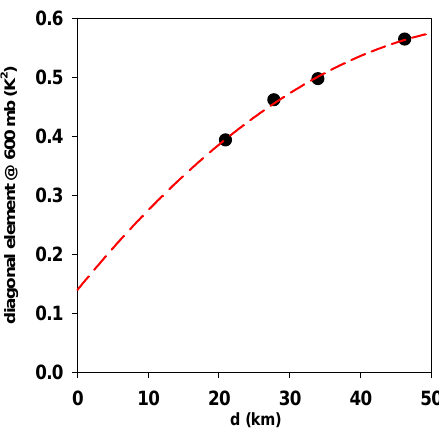
Fig. 2. Red dashed line is quadratic approximation of diagonal el- ements of the temperature structure function D (d) – black circles.